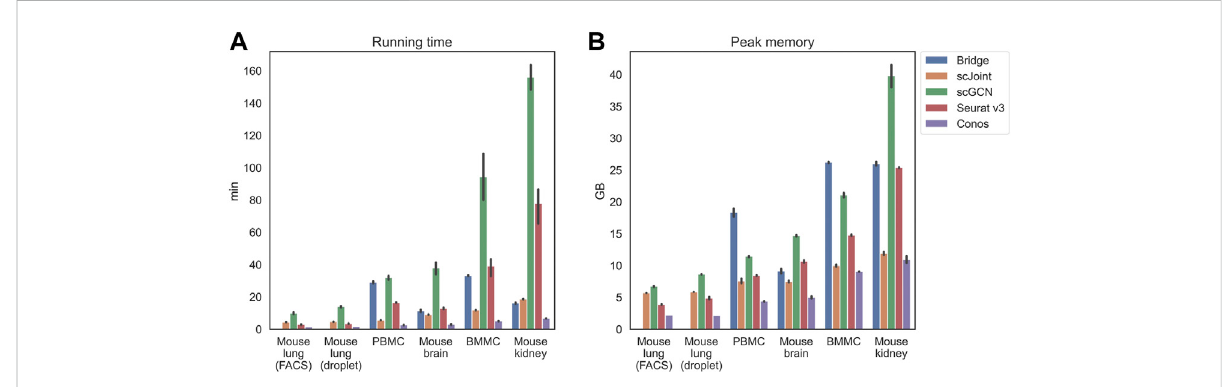
FIGURE 2 Running time (A) and peak memory usage (B) of differentmethods on selected tissues. Tissues are placed in the increasing order of their scales fromleft toright.For mouse lung (both FACS anddroplet),Bridge wasnot consideredbecauseofno available multimodal data.10independentruns were performed for each method and data combination and the error bars show the 95% con fi dence